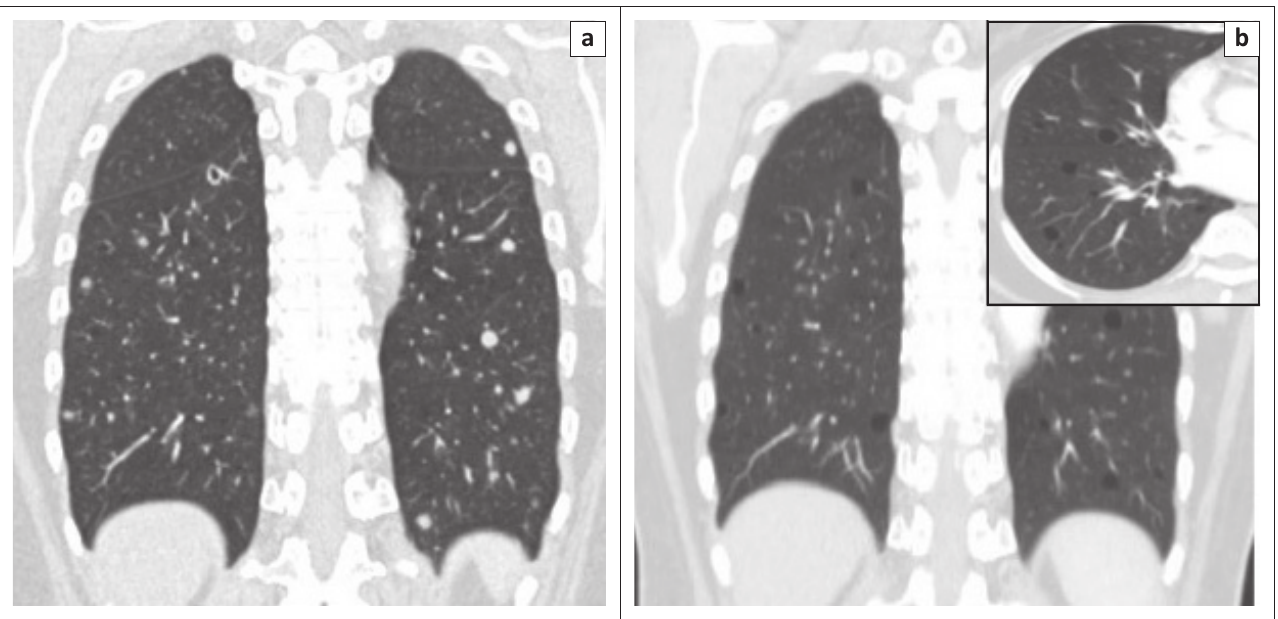
FIGURE 3: Coronal multiplanar reformatted images depicts the progression of solid pulmonary nodules to: (a) thick-walled cavitating nodules to (b) thin-walled pulmonary cysts over time. The uncomplicated thin-walled cysts are better appreciated in the magnified insert